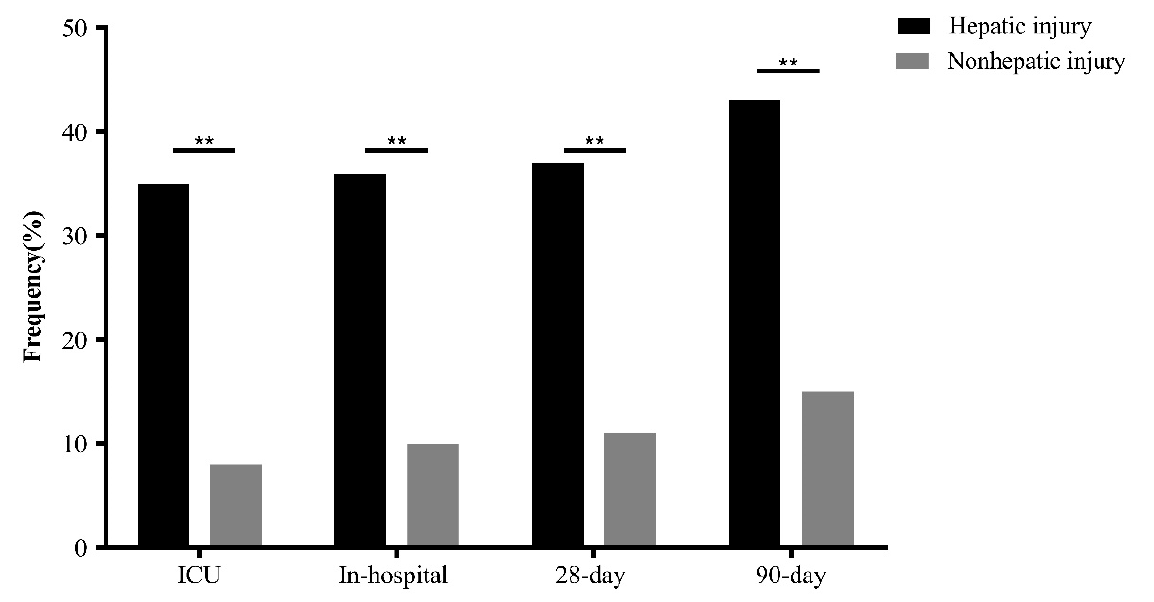
Figure 2. The mortality of AMI patients stratified by acute hepatic injury. **: p < 0.001. Table 1. Demographic and clinical characteristics of AMI patients stratified by acute hepatic in- jury.